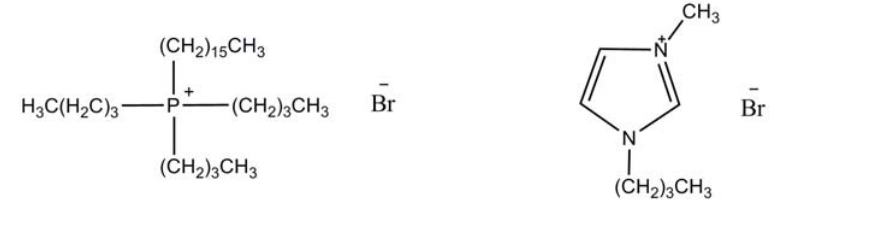
Figure 1. Two types of ionic liquids with various cations and the same anion.